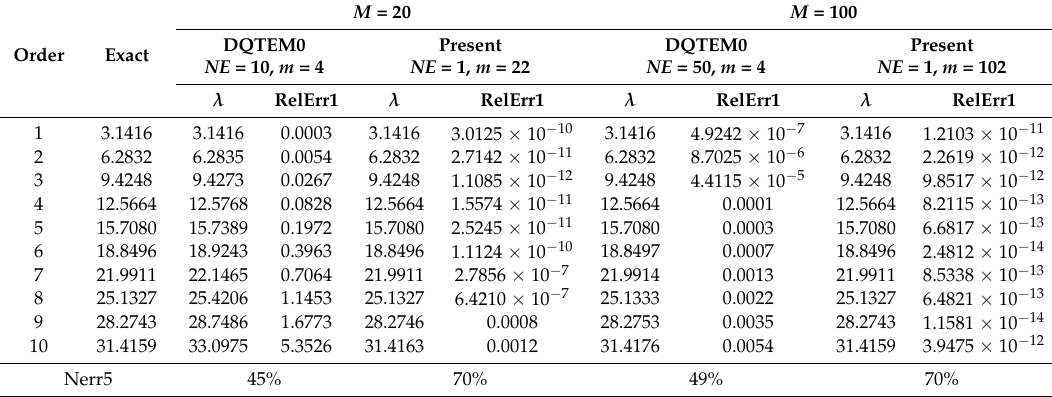
Table 7. Frequency comparisons of beam with the same spatial DOFs (Degrees of Freedom) for both methods.